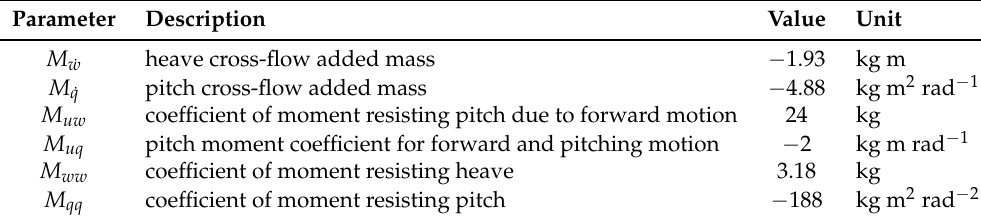
Table A6. Parameters of the pitch equation of motion taken from